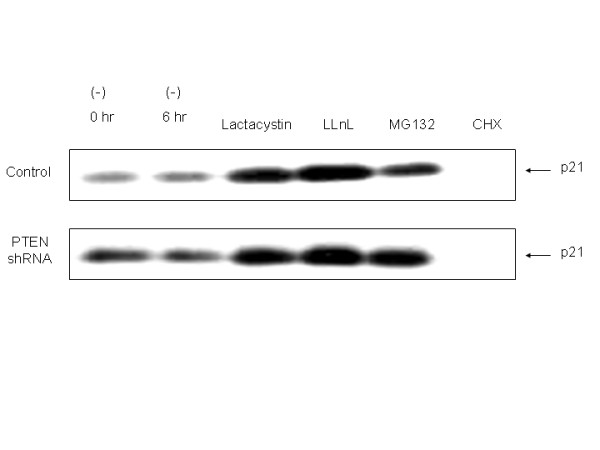
PTEN knockdown does not alter proteasome-dependent degradation. Cells stably transfected with PTEN-shRNA or empty vector were treated with three different proteasome inhibitors (lactastatin, 20 mM; LLnL, 50 mM; MG132, 1 mM) or cycloheximide (CHX; 20 μg/ml) for 6 h, followed by immunoblotting for p21. A representative experiment is shown of three done.